Question: Does the plotted quantity increase or decrease?
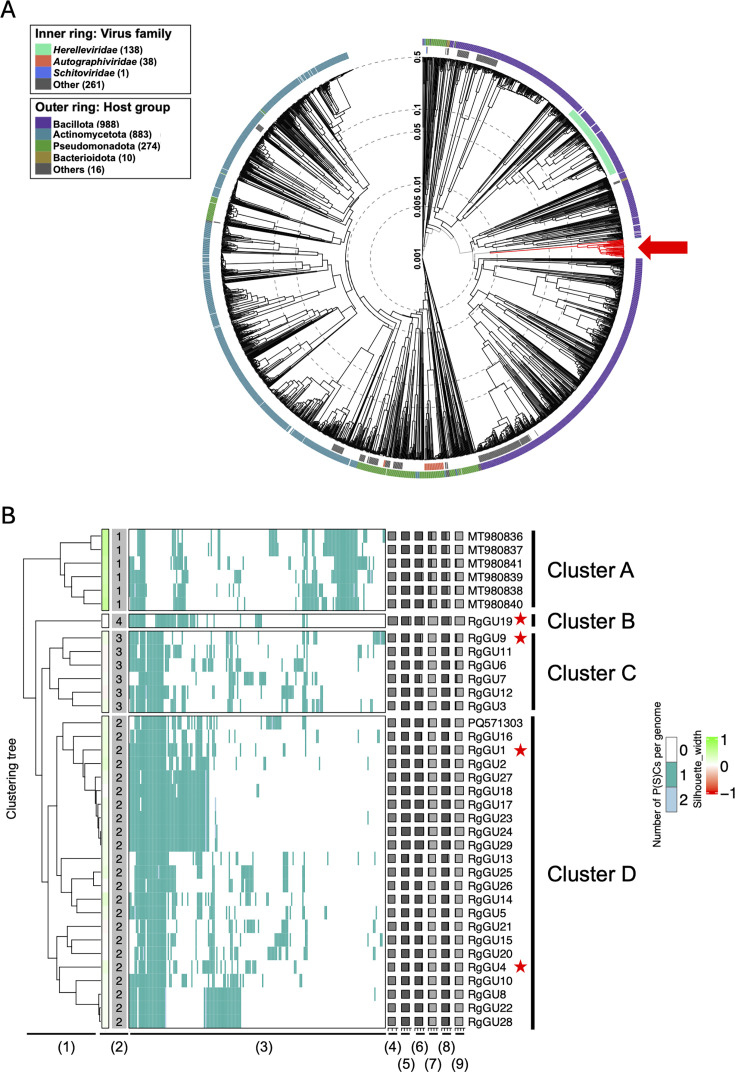
Answer: increasing